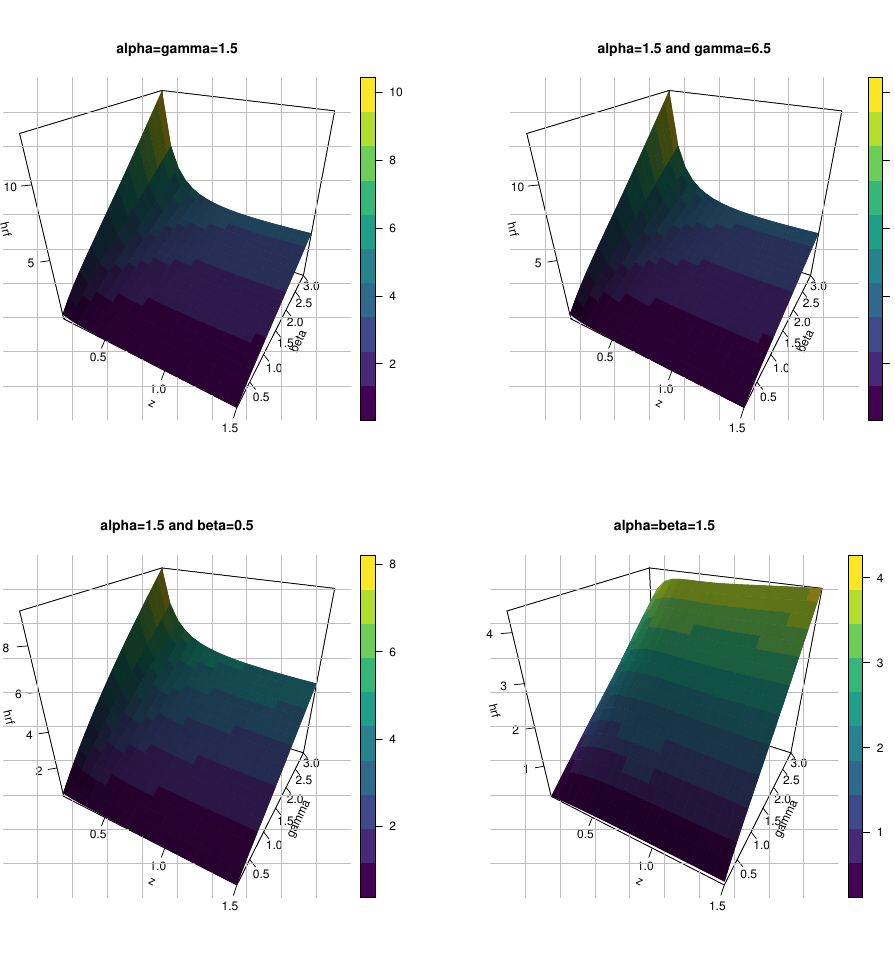
Figure 4. Plots of the hrf for the KMKE model in